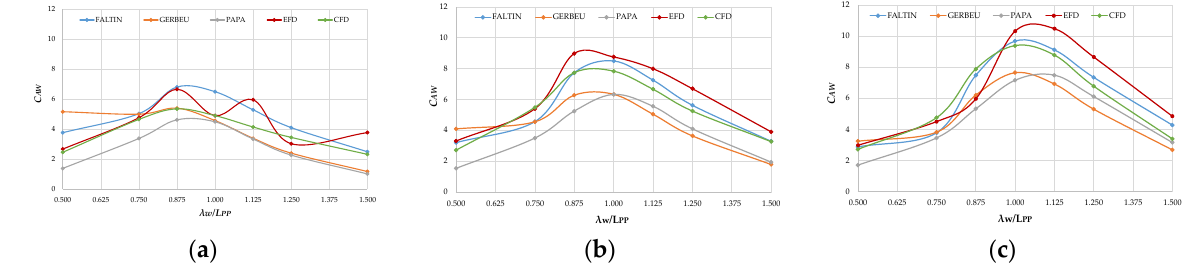
Figure 7. Comparisons of the results for added resistance coefficient: ( a ) 𝐹 𝑅 = 0.131; ( b ) 𝐹 𝑅 = 0.174; ( c ) 𝐹 𝑅 = 0.218.